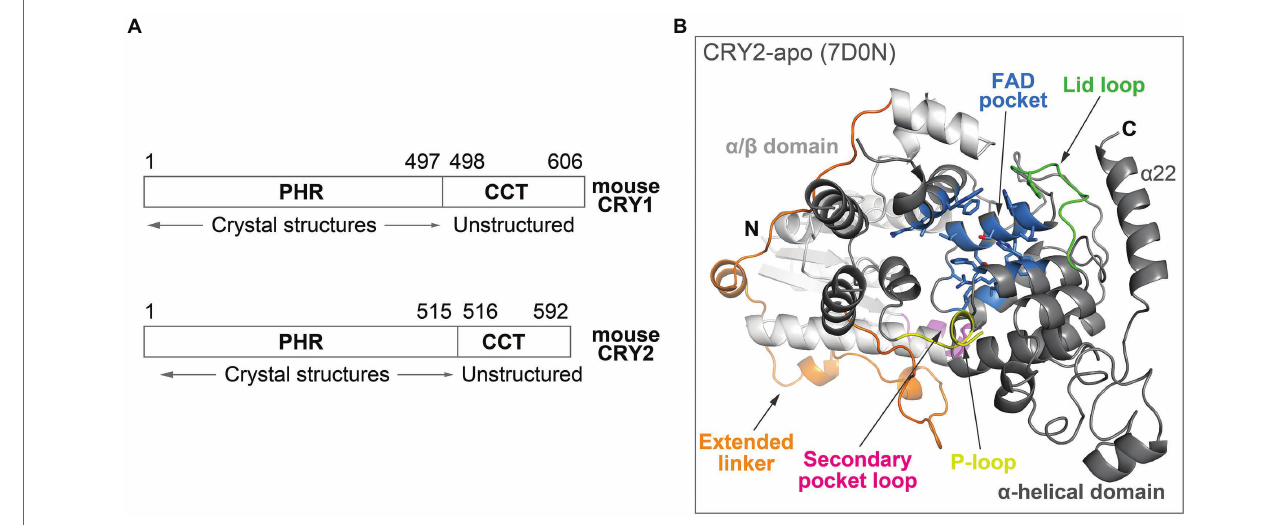
FIGURE 2 | Overall structure of mouse CRY. (A) Domain organization of mouse CRY1 and CRY2. The PHRs are highly ordered with ~80% sequence identity between CRY1 and CRY2, whereas the CCTs have divergent sequences, variable lengths and are predicted to be structurally disordered. (B) The crystal structure of the PHR domain of CRY2-apo (PDB ID: 7D0N). The N-terminal α / β domain (white) and C-terminal α -helical domain (gray) are connected by an extended linker (orange). Important structural and regulatory features include: The FAD pocket (blue), lid loop (green), P-loop (yellow), and secondary pocket loop